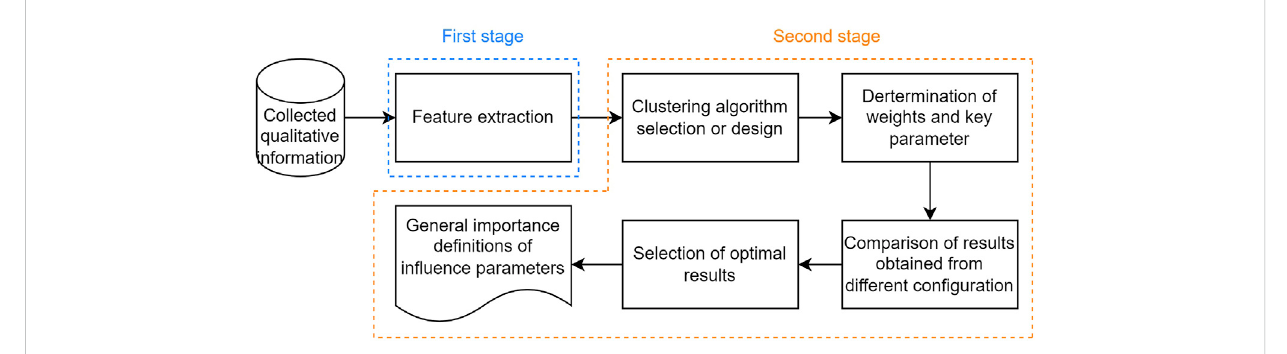
FIGURE 1 Flow diagrams of application of clustering analysis.